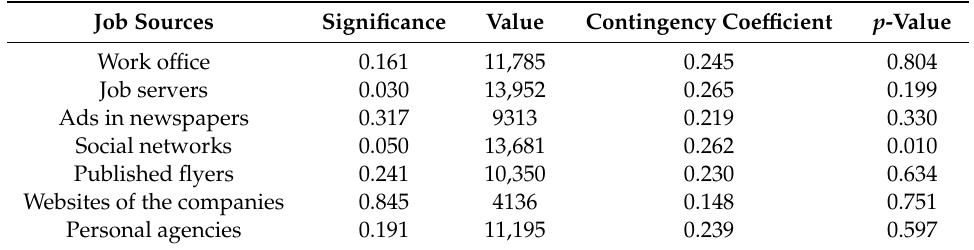
Table 2. Results of independence test between job searching sources and gender of